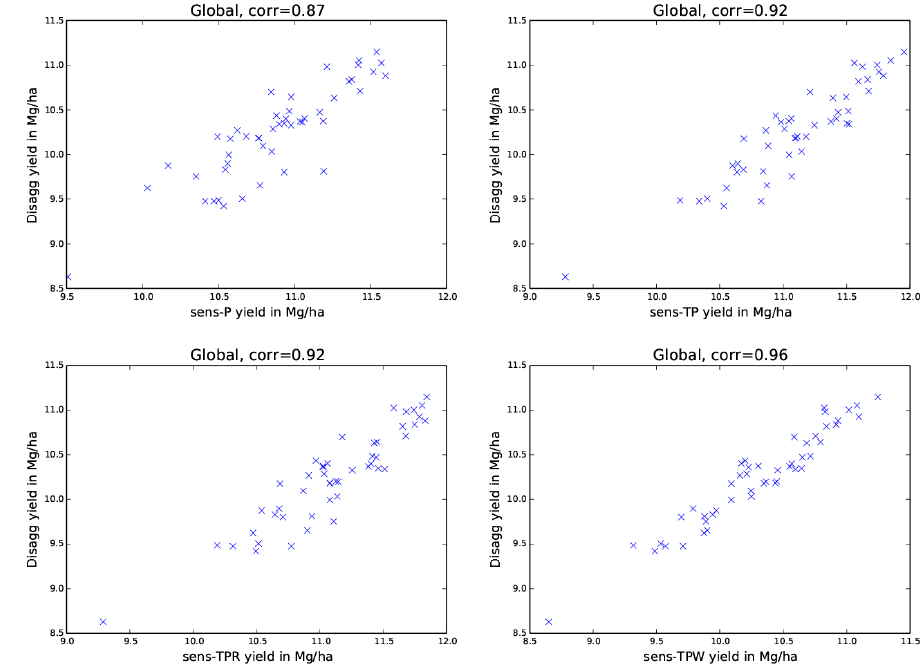
Figure A2. Scatter plots comparing the global mean maize yield from different model